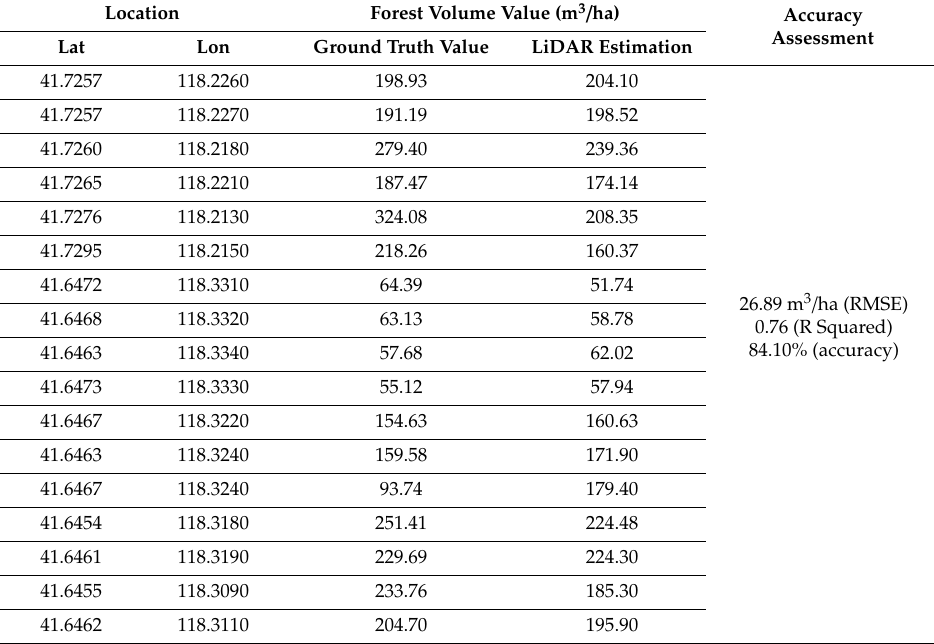
Table 5. Accuracy assessment table of forest volume map of UAV LiDAR.